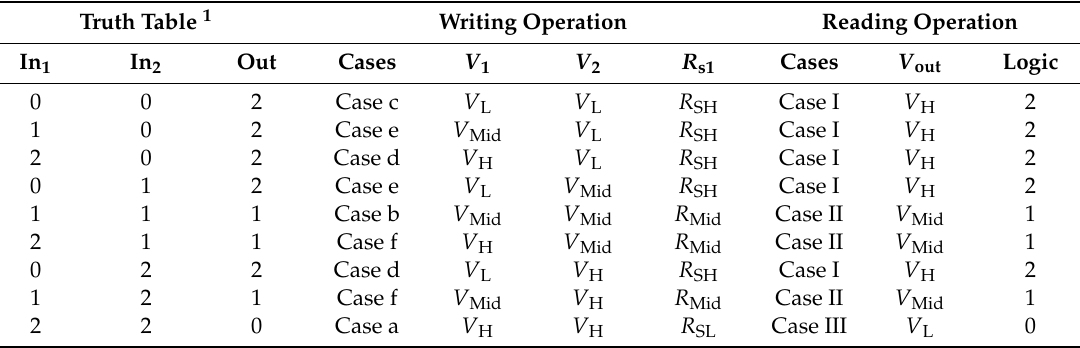
Table 2. A summary of the information of the ternary NAND